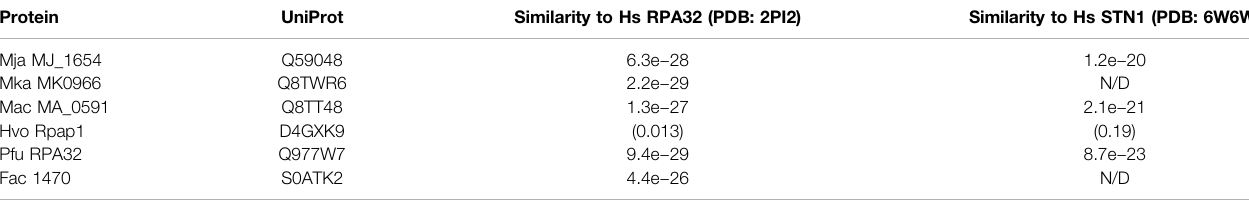
SearcheswereperformedagainstthePDB_mmCIF70databaseusingHHpredwithdefaultsearchparameters.ScoresarepresentedasE-valuesandre fl ectsimilarityacrossthefull-length ofthequeryproteinswiththeexceptionoftheE-valuesinbracketsforHvoRpap1whichindicatesimilarityovertheputativeC-terminalwHdomainonly.N/D,similaritytothewHdomainof the RPA32-like protein STN1 not detected by HHpred